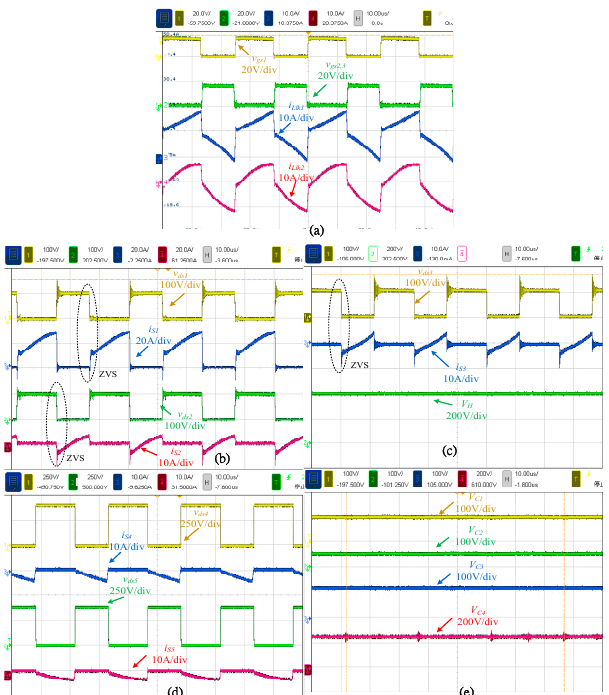
Figure 12. Experimental results obtained when operating the proposed converter at full load and a V L value of 48 V in the step-up mode: ( a ) waveforms of v gs1 , v gs2,3 , i Llk1 , and i Llk2 ; ( b ) waveforms of the v ds and i s values of S 1 and S 2 ; ( c ) waveforms of the v ds and i s values of S 3 and of the output voltage; ( d ) waveforms of the v ds and i s values of S 4 and S 5 ; and ( e ) waveforms of the voltages of C 1 , C 2 , C 3 , and C 4 .